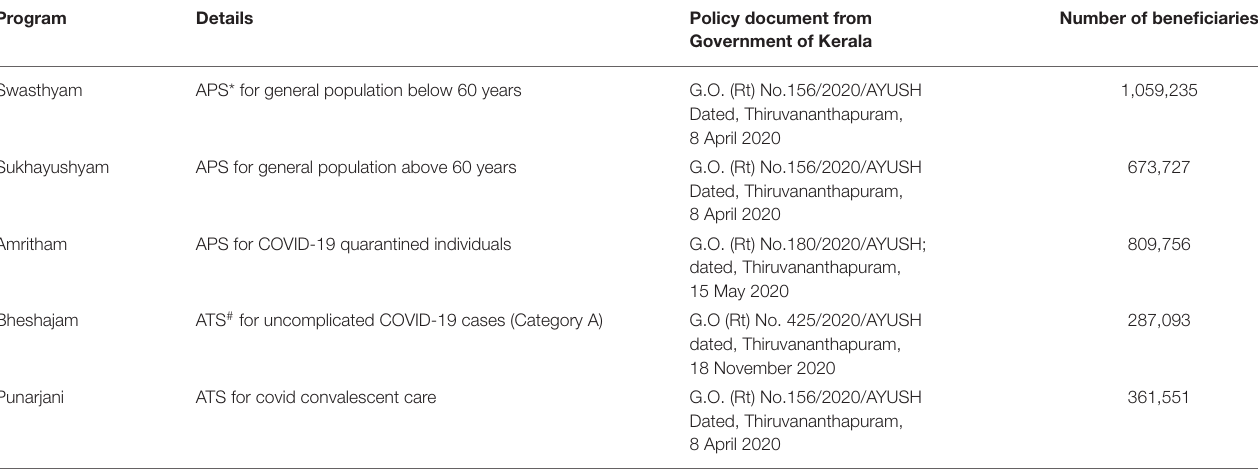
TABLE 1 | Details of various Ayurvedic programs for COVID-19 in Kerala as of 28 June 2021.